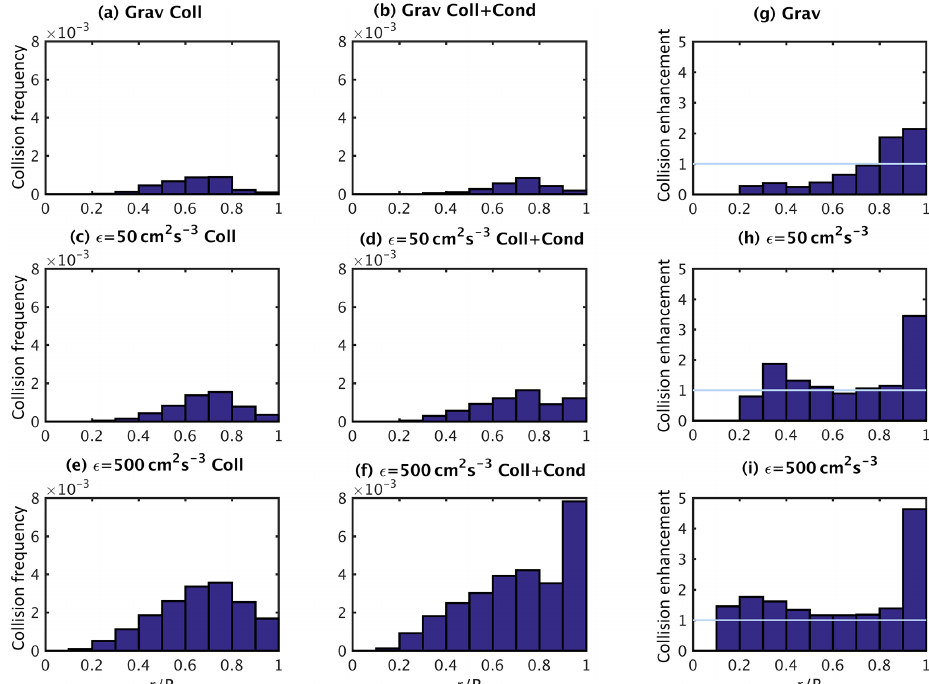
Figure 4. Panels (a–f) are the same as in Fig. 3 but for the collision frequency (cm − 3 s − 1 ) from different r/R pairs. Panels (g–i) are the enhancement of collision frequency for different r/R pairs due to the inclusion of condensation. The enhancement is calculated by taking the ratio of the collision frequency from the condensation–collision experiment and the collision-only experiment. Results from three different flow conditions are demonstrated.